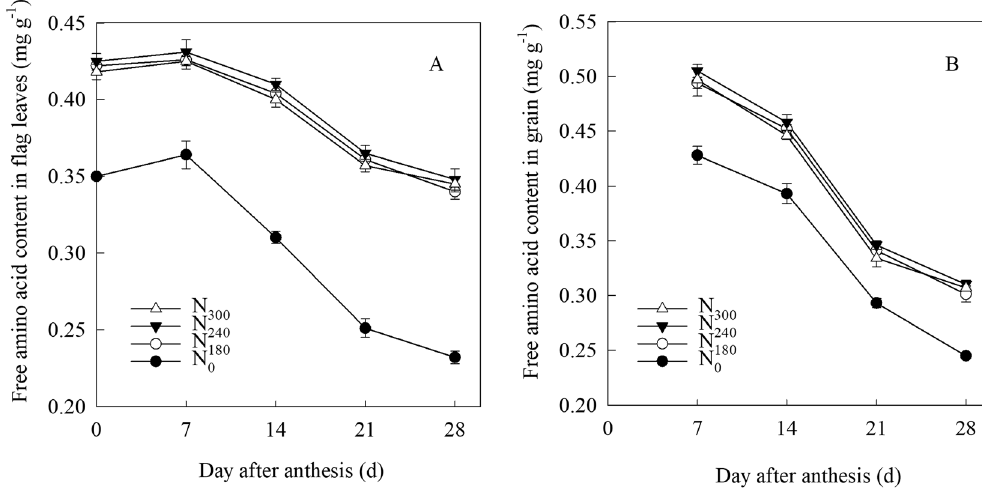
Figure 1. Changes of free amino acid content in wheat flag leaf ( A ) and grain ( B ) under different N treatments in 2016/2017. N